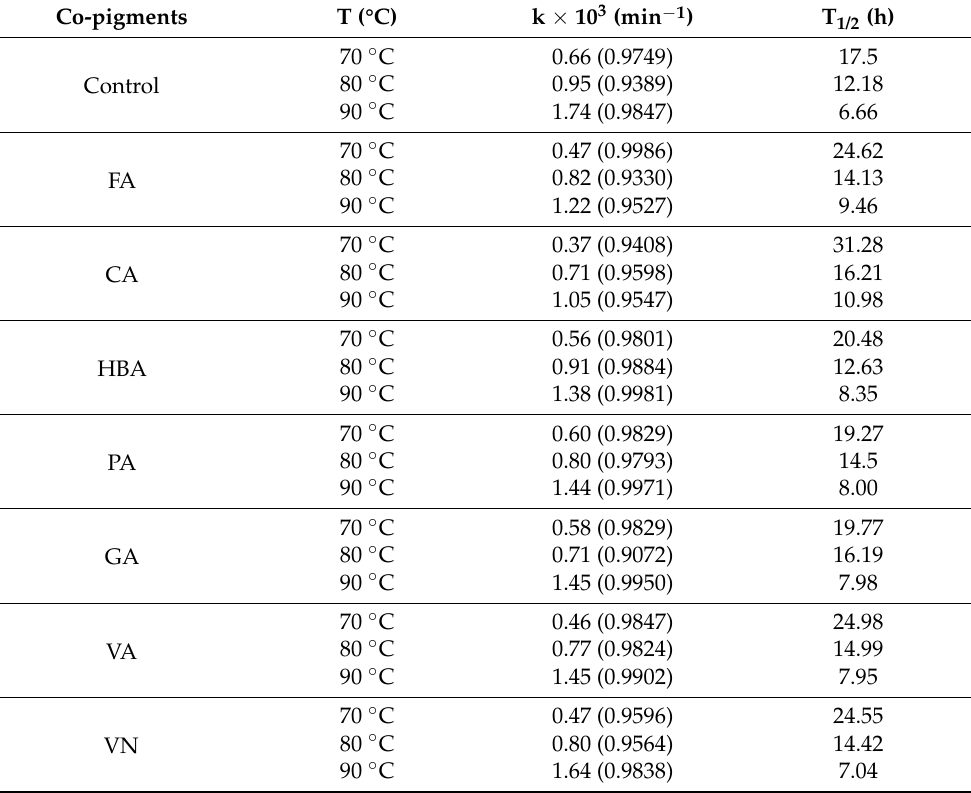
Table 2. The thermal gradation kinetic parameter for of mulberry anthocyanins at different